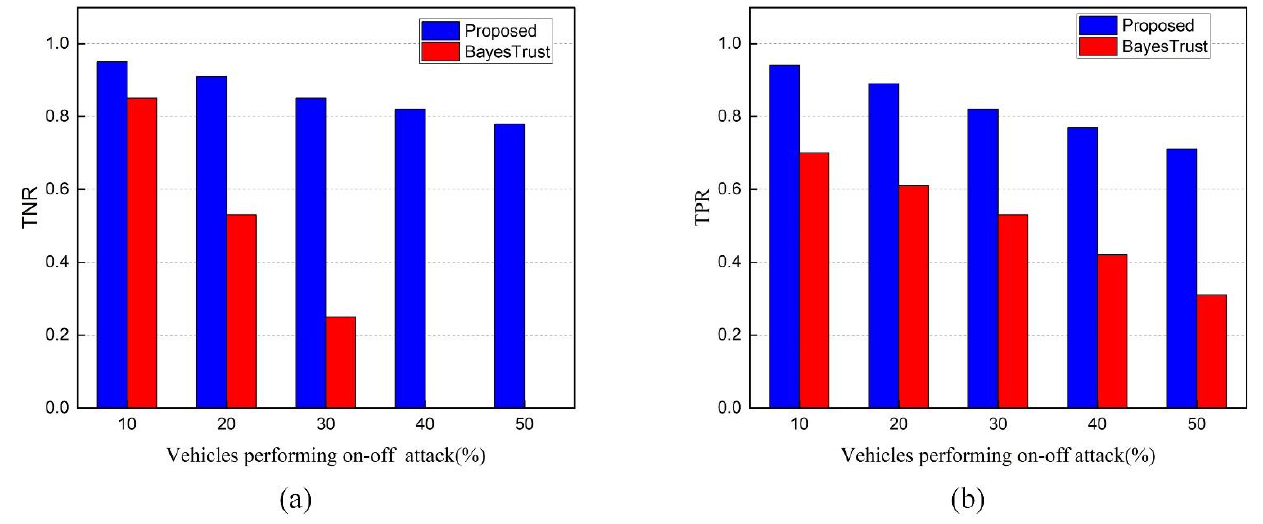
Figure 10. Experiments ( a , b ) represent TNR and TPR under On-off attack. Trust metric